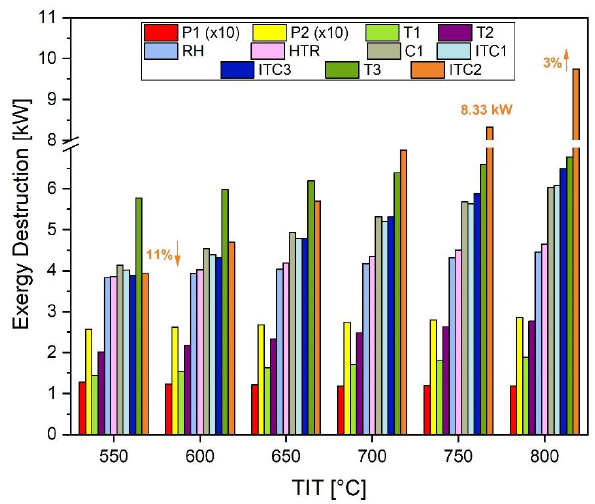
Figure 8. Components destroyed exergy with respect to turbine inlet temperature (TIT).